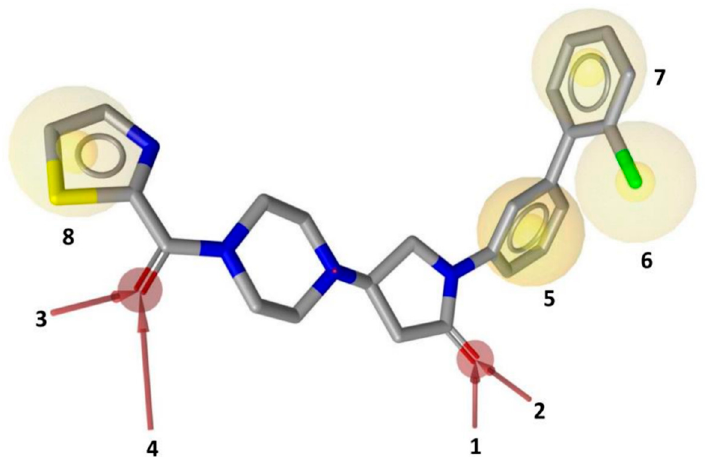
Figure 2. Receptor-based pharmacophore model with mandatory features 1 – 5 and optional features 6 – 8 superimposed with MAGL inhibitor 3l in the X-ray complex.